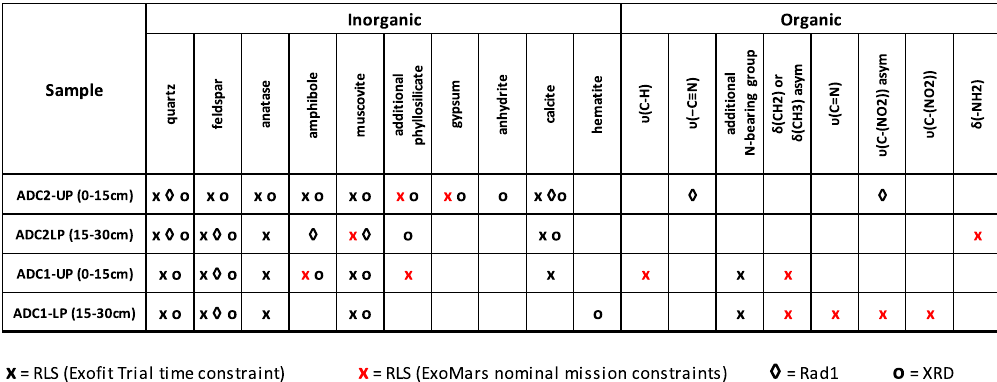
with this instrument varied between 9 and 12, which is below the minimum number of analysis per core that are expected to be carried out on Mars (20). This can be explained by the fact that the time dedicated to the in-situ study of drilled cores was narrowed due to logistic reasons (two RSM measurement cycles needed to be compressed within a time frame of 10 sols). However, additional spots were analysed to reach a total of 39 spectra per sample, being this the maximum number of analysis to be nominally performed on regular opera- tions on Mars. The results described below are based on the complete set of Raman data gathered from each sample, although the summary provided in Table 1 allows one to distinguish the minerals detected within the ExoFiT-constrained time frame (black cross) from those additionally detected using nominal ExoMars mission parameters (red cross). Starting from the ADC2 core, both UP and LP subsamples showed Raman features from quartz (main peak at 464 cm −1 and secondary signals at 124, 202, 263, 354, 805 and 1159 cm −1 , Fig. 3a), anatase (TiO 2 , main peaks at 142, 394, 510 and 634 cm −1 , Fig. 3b) and feldspar. By comparing the vibrational profile of feldspar spectra, different mineral phases were identified. For example, the positions of the peaks detected in the spectrum shown in Fig. 3c (main signals at 478 and 508, together with minor peaks at 167, 286, 409, 566, 763, 809 and 1100 cm −1 ) matched perfectly with the Raman features from albite 43 , being this mineral the Na-rich end member of the plagioclase subgroup (NaAlSi 3 O 8 ). As displayed in Fig. 3d, further spectra matched with anorthite reference spectrum (peaks at 150, 276, 401, 473, 515, 756, 799 and 1120 cm −1 , confirming the additional presence of